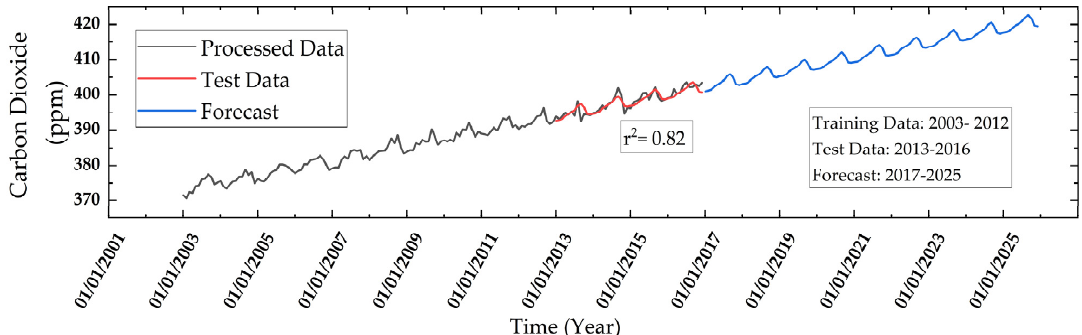
Figure 6. Temporal variations of monthly mean CO 2 in the study area during 2003–2016 and forecast during 2016–2022 using linear regression.